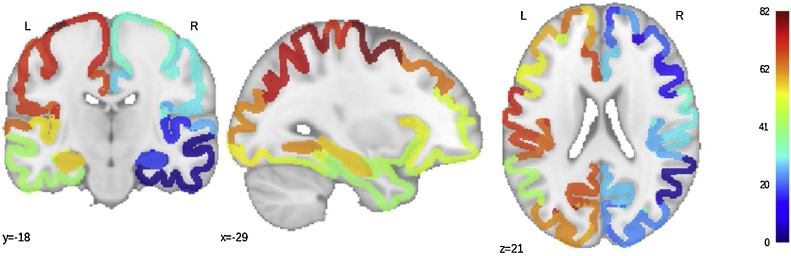
Cortical regions from the Bezgin et al. (2012) atlas in MNI space.